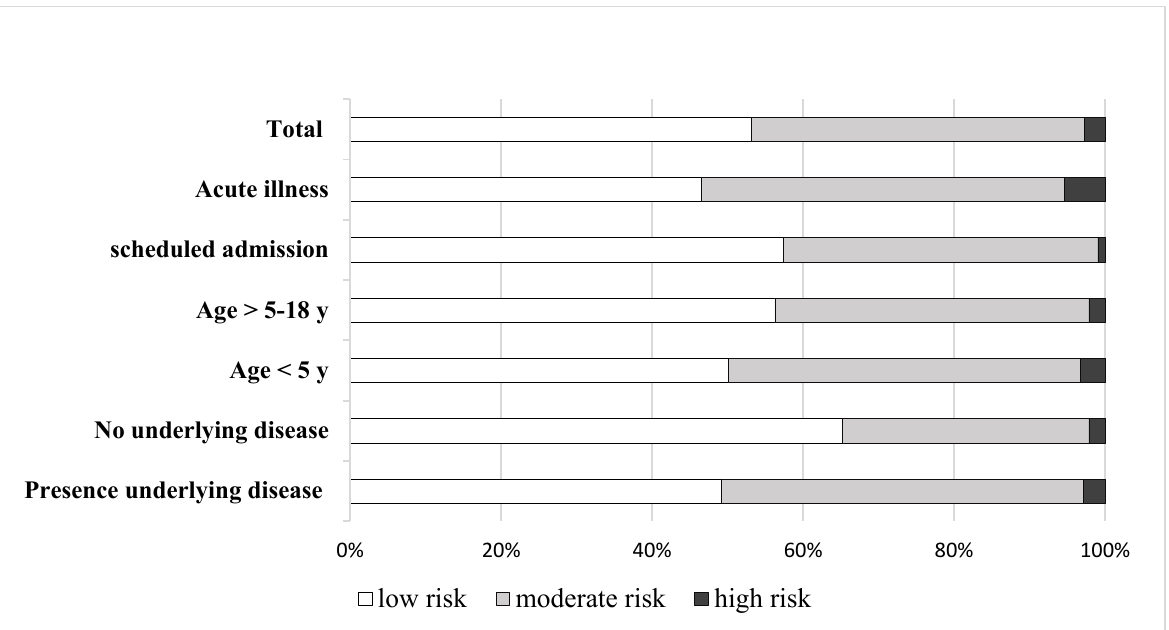
Figure 2. Nutrition risk score (STRONGkids) classified by patients’ characteristics.